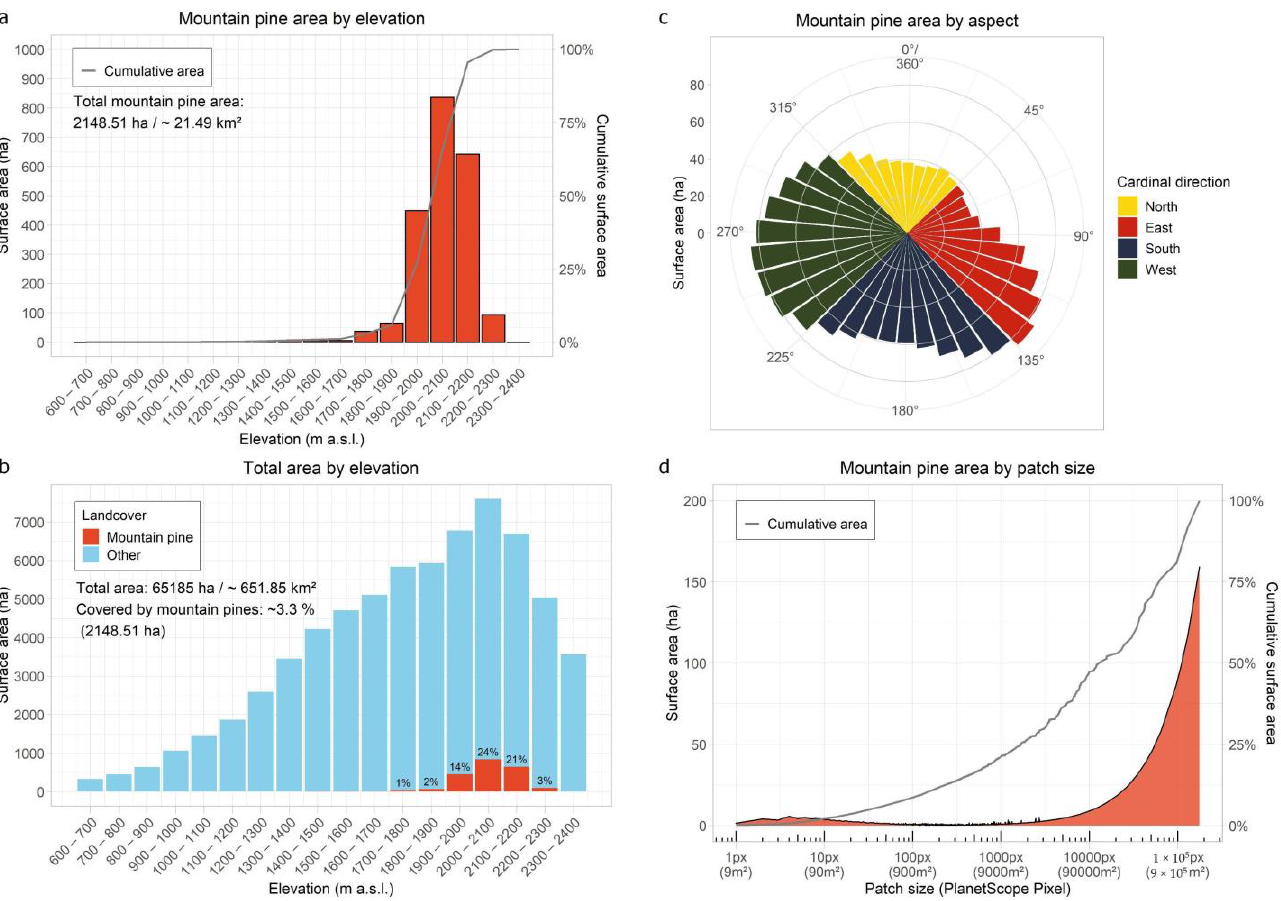
Figure 9. Landscape metrics for mountain pine stands in the Sarntal Alps, South Tyrol, based on final classification result (PS + GLCM MAX + Topo + CHM). ( a ) Surface area covered by mountain pines at different altitudes; ( b ) relative land cover of mountain pines at different altitudes; ( c ) surface area covered by mountain pines by cardinal direction; ( d ) surface area by mountain pine patches at different patch sizes.